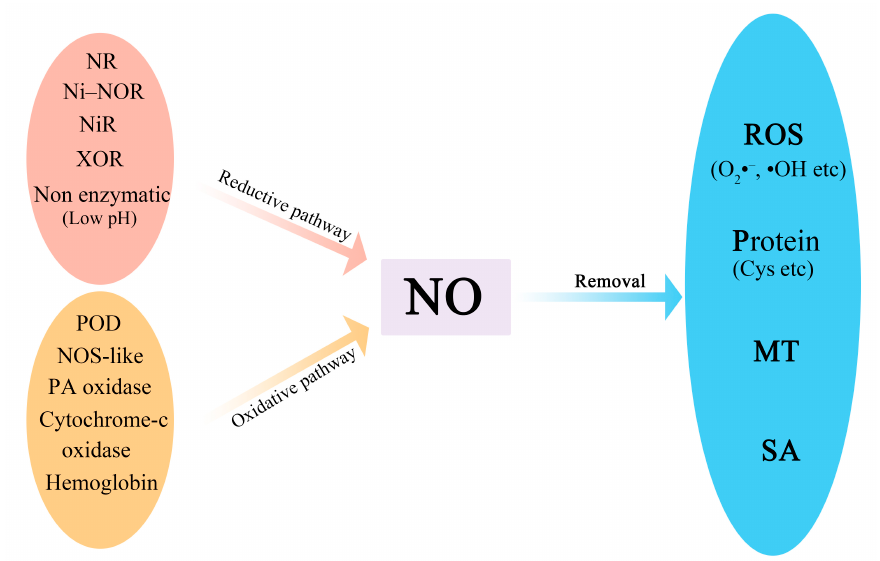
Figure 1. A schematic model of NO synthesis and removal. NO is synthesized via the reductive pathway and the oxidative pathway. The enzymes for the reductive pathway include NR, Ni–NOR, NiR, and XOR. Non-enzymatic nitrite reduction occurs spontaneously under low pH. POD, NOS-like, PA oxidase, cytochrome-c oxidase, and hemoglobin are involved in the oxidative pathway. NO can be removed by reaction with ROS, proteins, MT, and SA. NR: nitrate reductase; Ni–NOR: nitrite–NO reductase; NiR: nitrate reductase; XOR: xanthine oxidoreductase; POD: peroxidase; PA: polyamine; MT: melatonin; SA: salicylic acid.